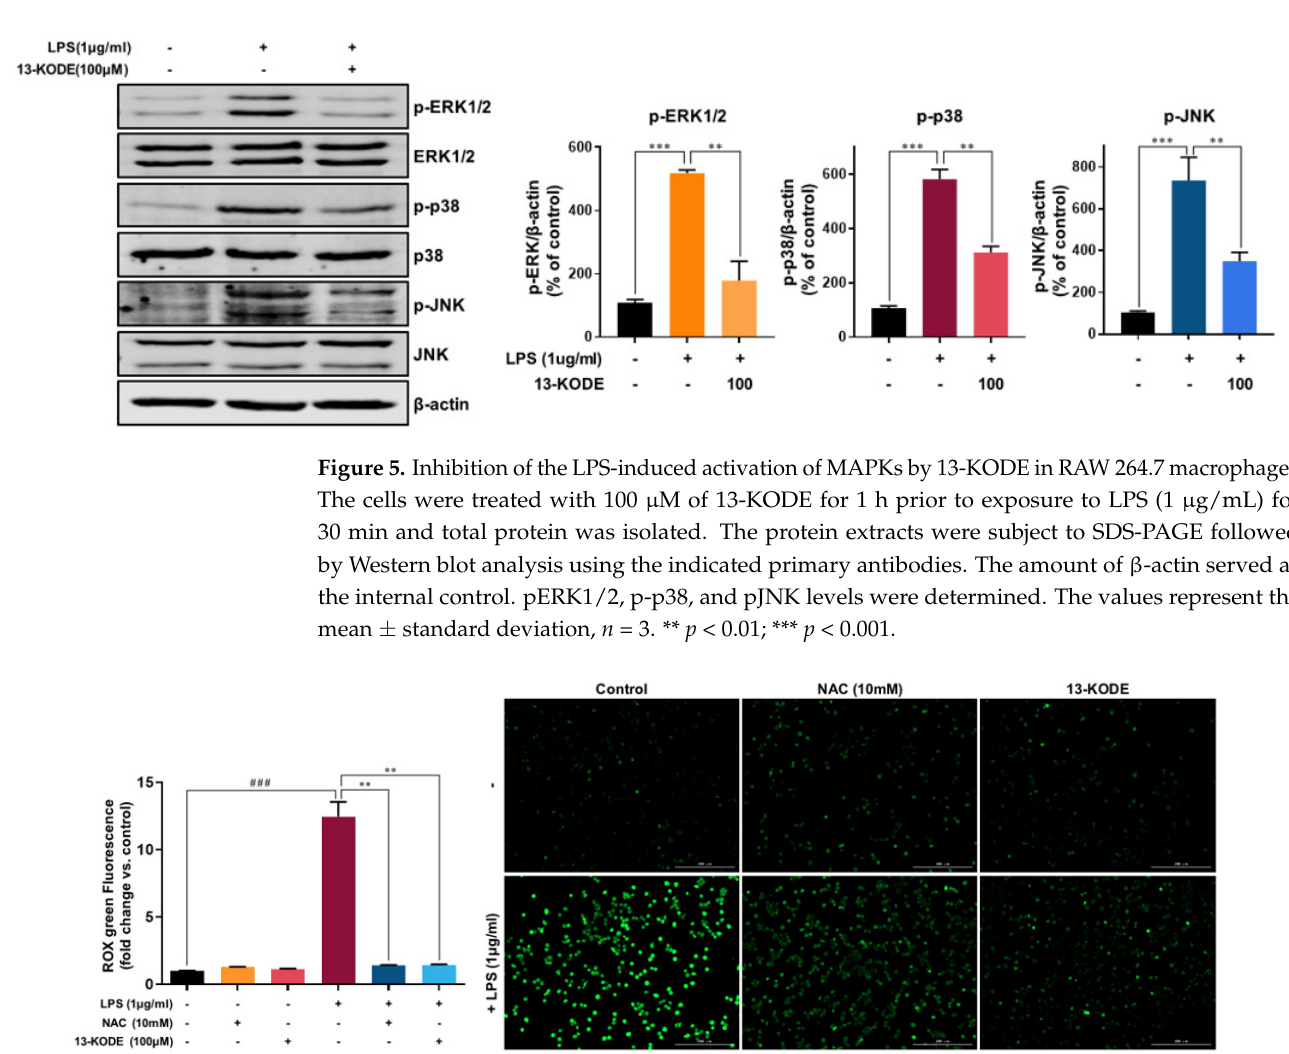
Figure 6. Effect of 13-KODE on LPS-induced ROS generation in RAW 264.7 macrophage cells. The ROS production of RAW 264.7 macrophages was monitored using CellROX Green dye assays. Macrophage cells were pretreated with 100 µ M of 13-KODE and NAC (10 mM) for 1 h prior to treatment with or without 1 µ g/mL LPS for 30 min. ROS data were visualized using a fluorescence microscope (magnification, × 100) and representative photos are shown (scale bar; 100 µ m). The values represent the mean ± standard deviation, n = 3. ** p < 0.01 ### p < 0.001.